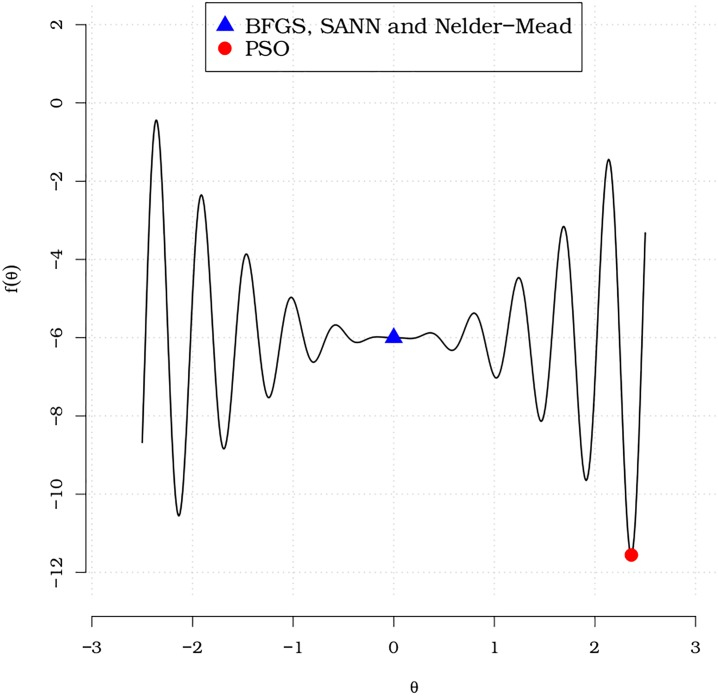
f(θ) = 6 + θ2 sin(14θ) with global minimum estimates.